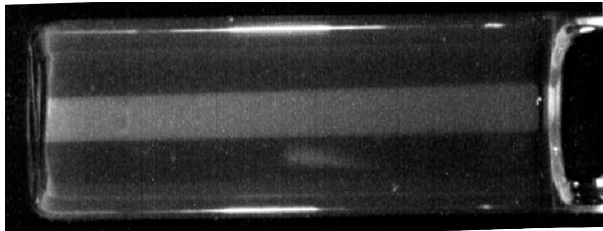
Figure 8. The image of a 5 × 5 mm 2 200 kVp X-ray beam propagating in a 60 mm length of RFG gel contained in a 20 × 20 mm 2 cell. Optical artifacts occur at the glass/air sides of the cell and at the gel meniscus.